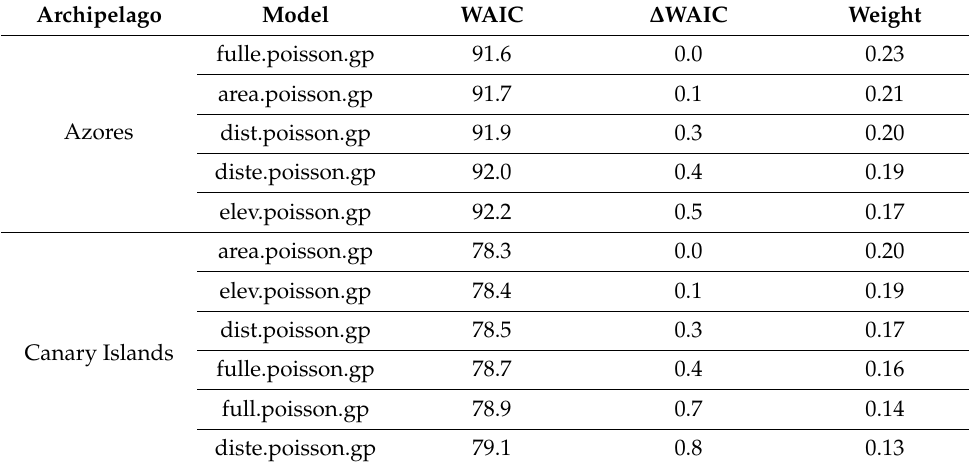
Table 6. Comparison of the several models using the “Widely Applicable Information Criterion” (WAIC) criterion for all species. Only models with ‘weight’ greater than 0.01 are shown. See the caption of Table 3 for the explanation of the acronyms “ ∆ WAIC” and “weight”.